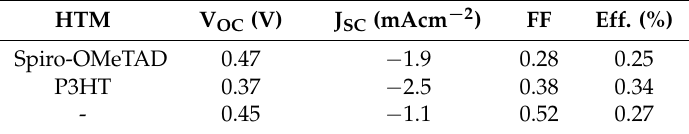
Table 1. Device parameters from the devices shown in Figure